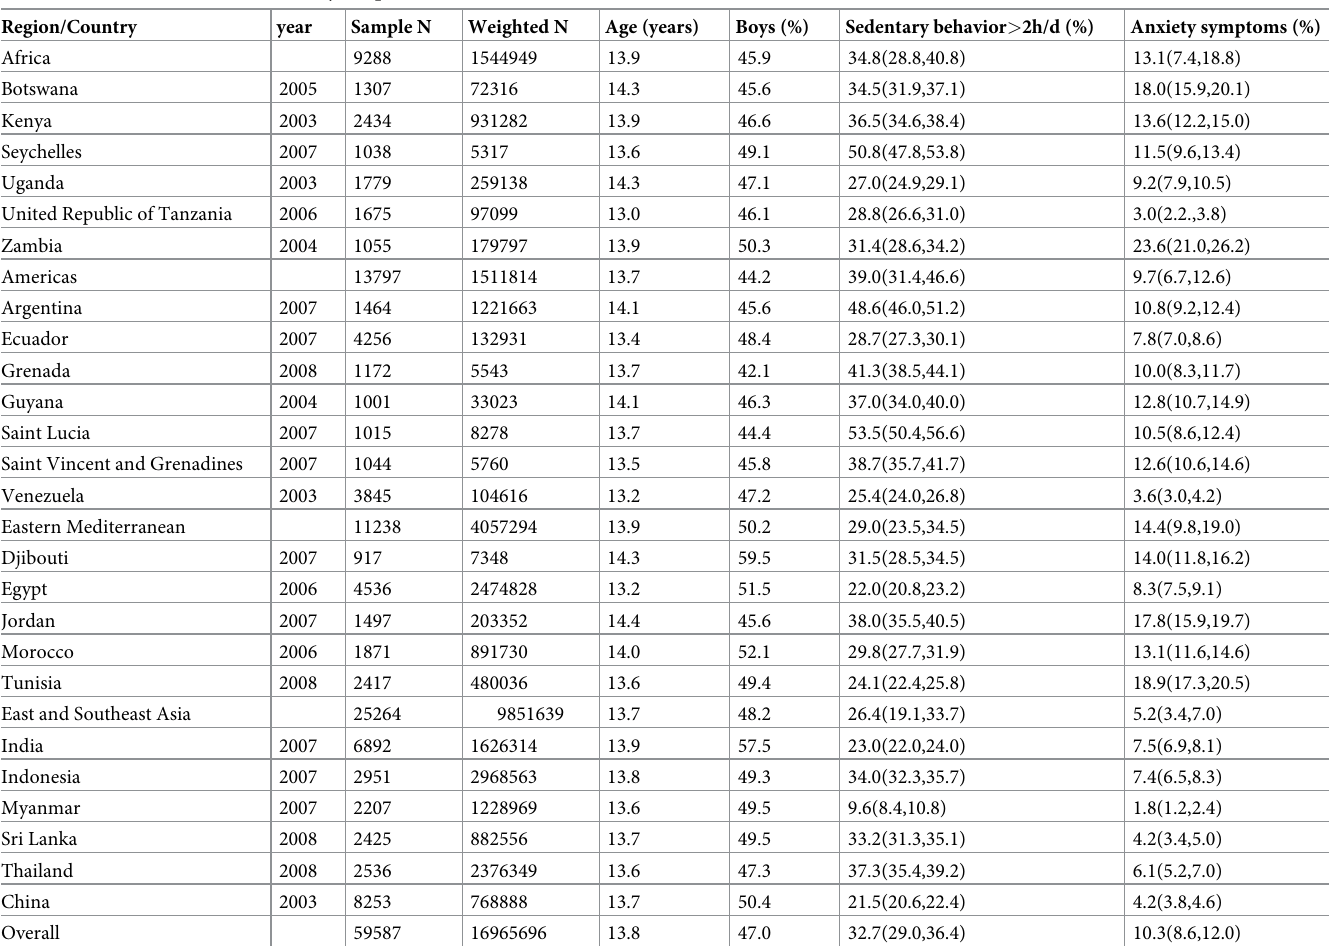
Table 1. Basic characteristic of the study sample a